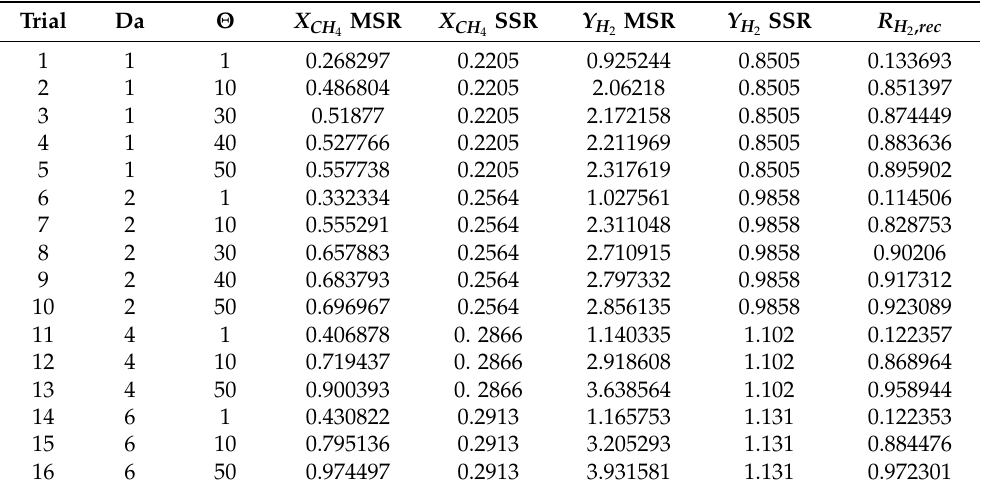
Table 4. Performance metric comparison for SMR-MSR and SMR-SSR for the sixteen considered